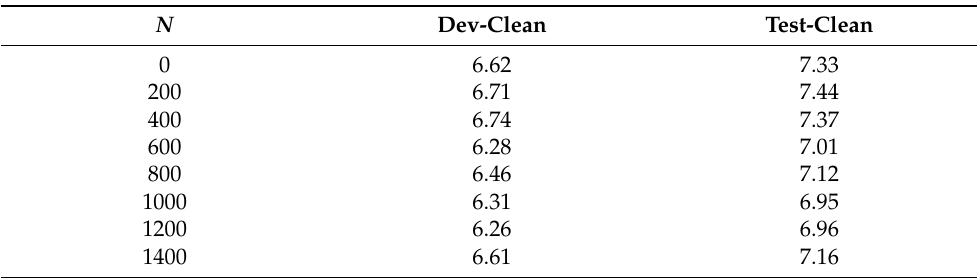
(cid:1840) when (cid:1871)~Uniform(cid:4670)0.9,1.1(cid:4671) .